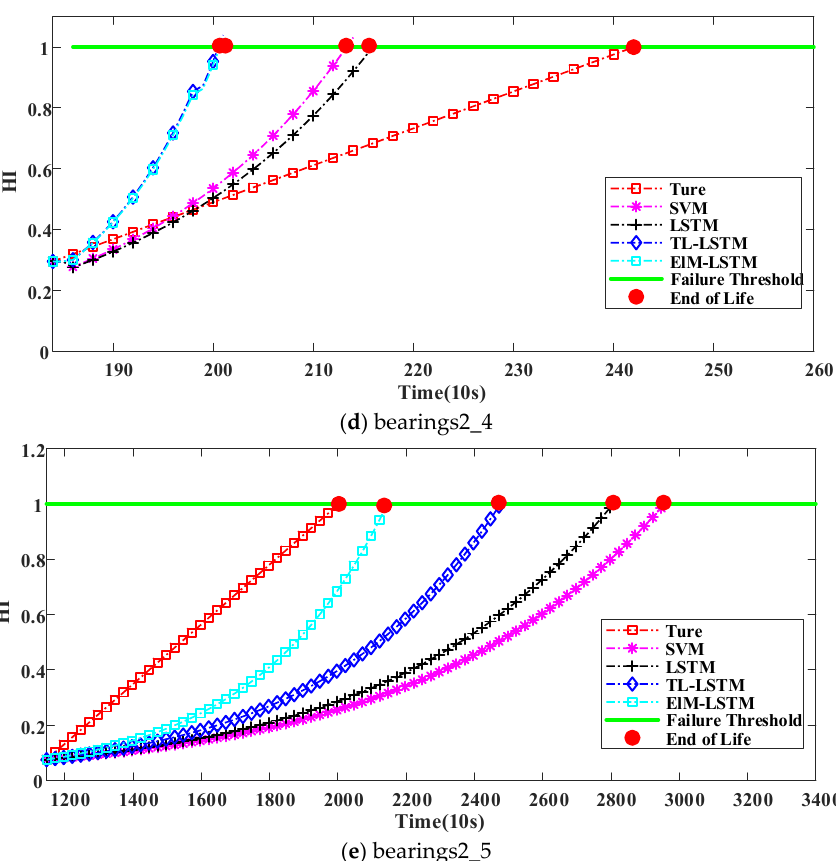
Figure 11. Results of RUL prediction for bearings2_1, bearings2_2, bearings2_3, bearings2_4, and bearings2_5.